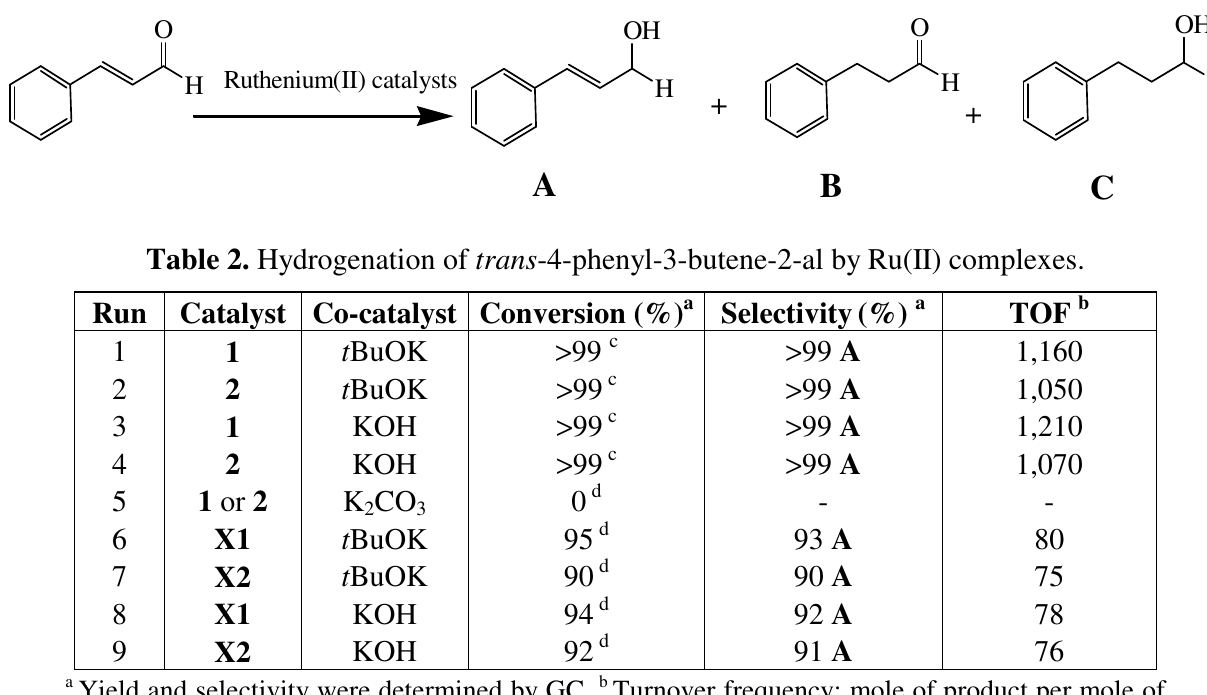
Scheme 2. Different hydrogenation possibilities of trans -4-phenyl-3-butene-2-al: Selective